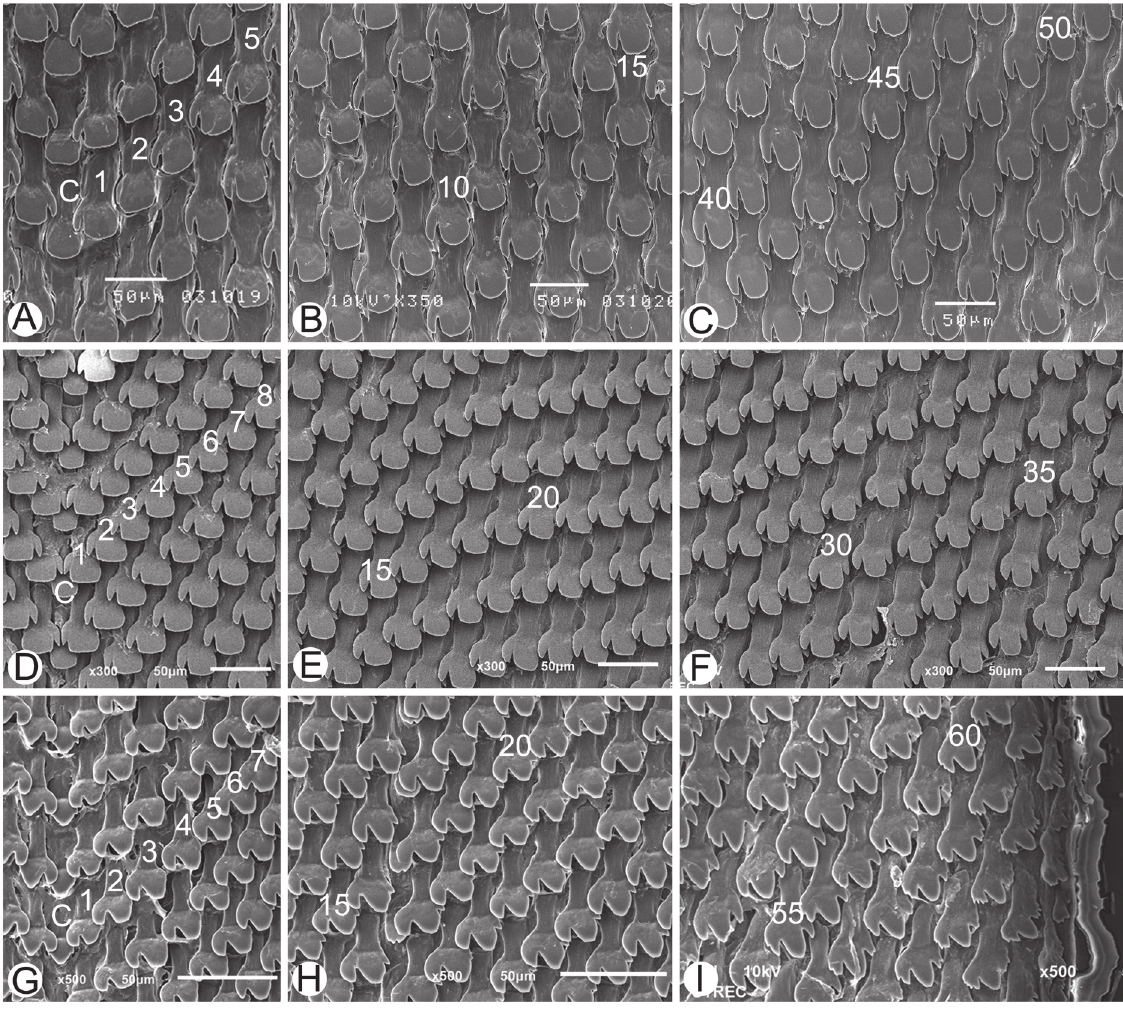
Fig. 7. SEM images of the radula. A–C . Amphidromus roseolabiatus Fulton, 1896 from Ban Phavong, Khammouan, Laos (CUMZ 7012). D–F . Amphidromus syndromoideus sp. nov., holotype (CUMZ 7019). G–I . Amphidromus areolatus (Pfeiffer, 1861) from Thad Fek, Attapue, Laos (CUMZ 7023). A, D, G = central tooth with the first to fifth to eighth lateral teeth; B, E, H = lateral teeth with the tricuspid marginal teeth transition; C, F, I = outermost marginal teeth. Numbers indicate the order of the lateral and marginal teeth. Central tooth indicated